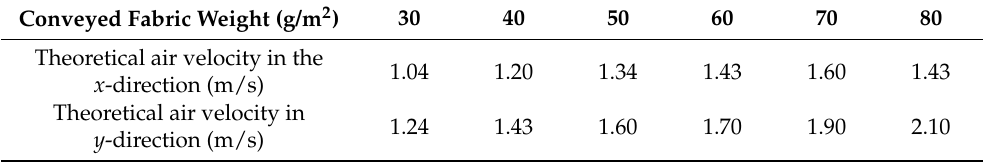
Table 5. Theoretical flow rate of the air outlet when the conveyed fabric has different gram weights. Conveyed Fabric Weight (g/m 2